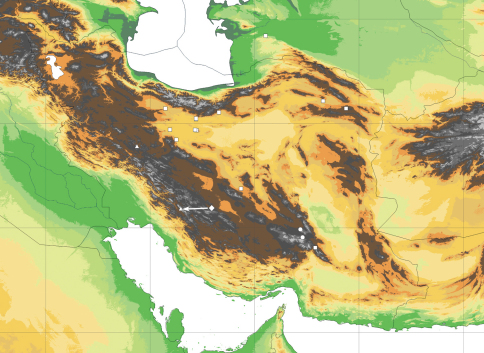
Distribution of Lactuca hazaranensis (circles) and the related species Lactuca rosularis (squares) and Lactuca denaensis (rhomb, actucal position as indicated by arrow), as well as of Cicerbita polyclada (triangles). – Georeferenced map based on the known collections (see Appendix and supplemented by collection cited in Kirpicznikov 1964 and Tuisl 1977) and generated with DIVA-GIS (Hijmans 2011) using an adaptation of the SRTM 90 m digital elevation data (CGIAR-CSI 2004).